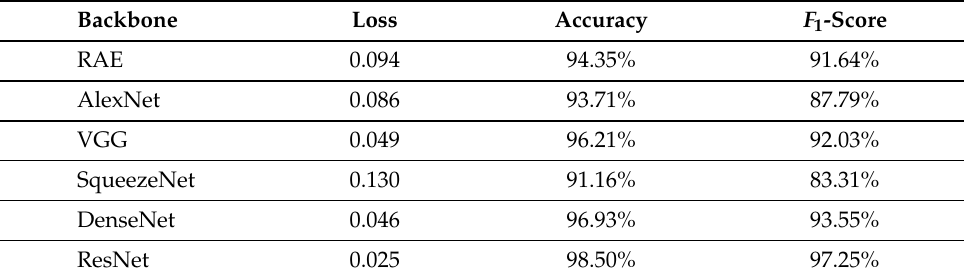
Table 3. Top-1 Accuracy and F 1 -score on 5K EPP training set.